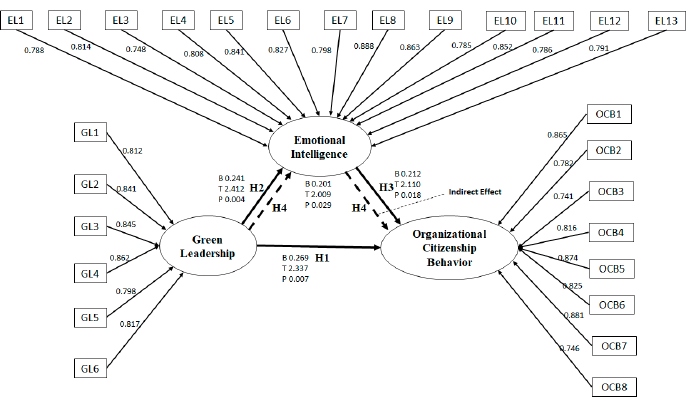
Figure 2. Results of PLS-SEM analysis.